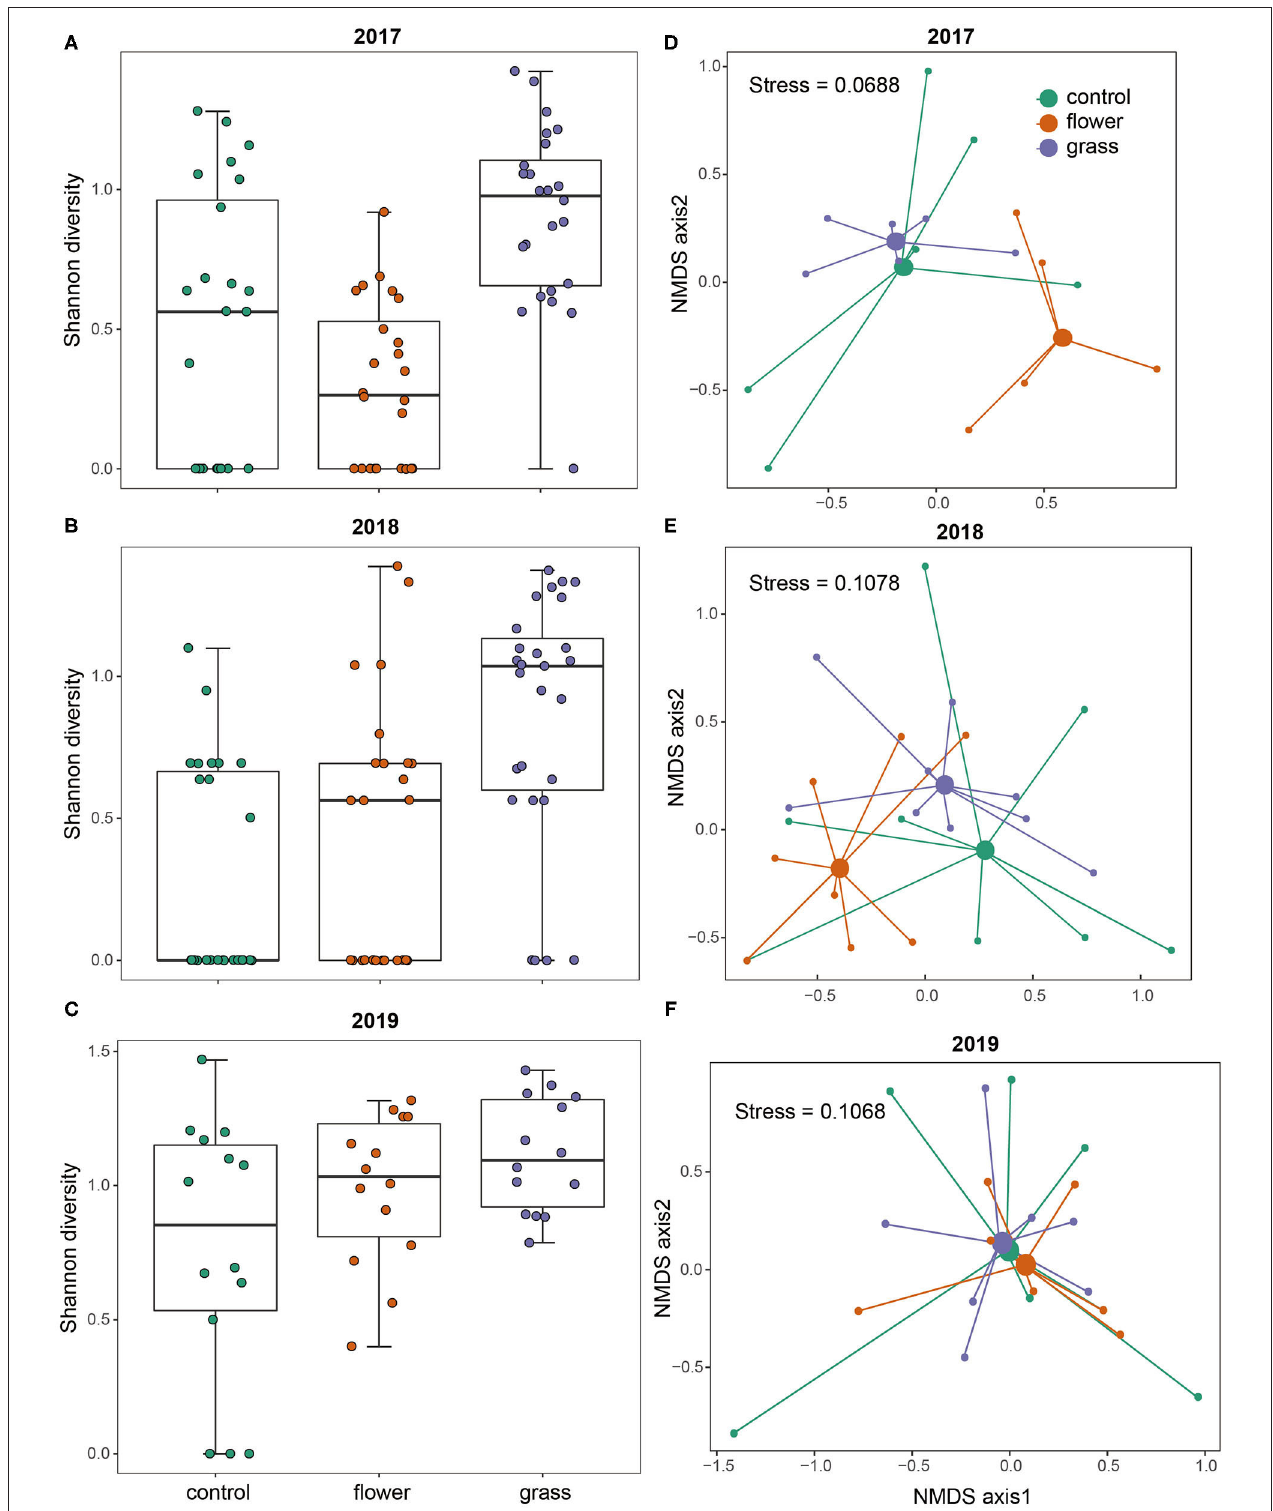
FIGURE 2 | Diversity and community structure of the predators in the control, flower, and grass cover plants during the 3 years (2017–2019). Each year is presented separately: 2017 (A,D) , 2018 (B,E), and 2019 (C,F) . NMDS plots are presented based on Bray–Curtis similarity.